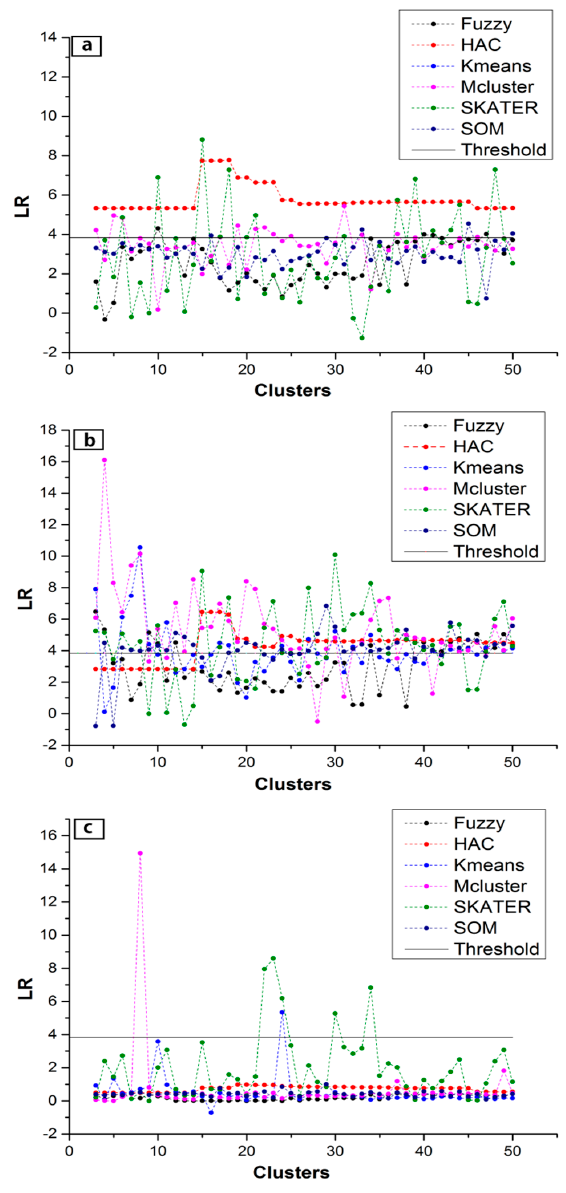
Figure 3. The log-likelihood statistic of the multilevel models regarding PSI contextual values and citizens’ perceptions of: ( a ) the self-perceived health status; ( b ) perceptions of neighborhood safety; ( c ) perceptions of neighborhood social cohesion.